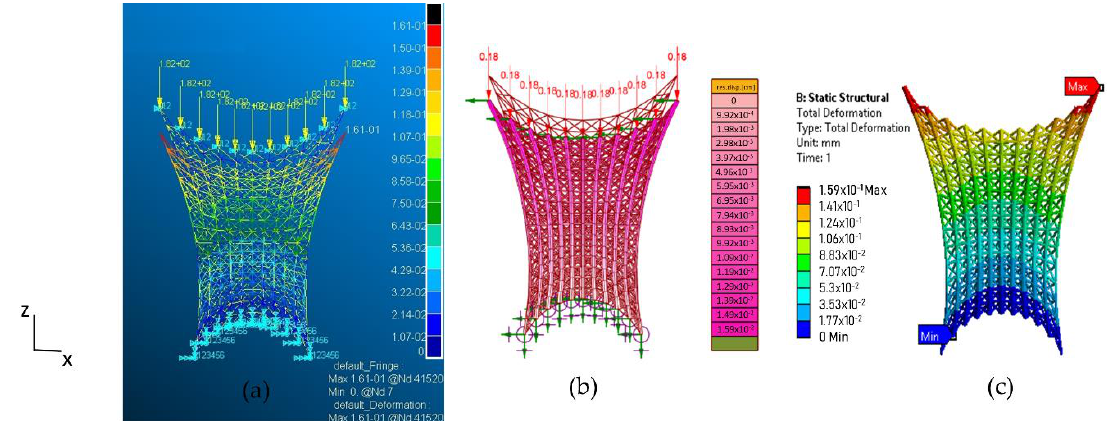
Figure 9. FEA deformation results for the BBC lattice structure during the compression load case. Deformation scale: 40 times. ( a ) MSC Patran/Nastran, ( b ) Karamba3D, and ( c ) ANSYS Mechanical.